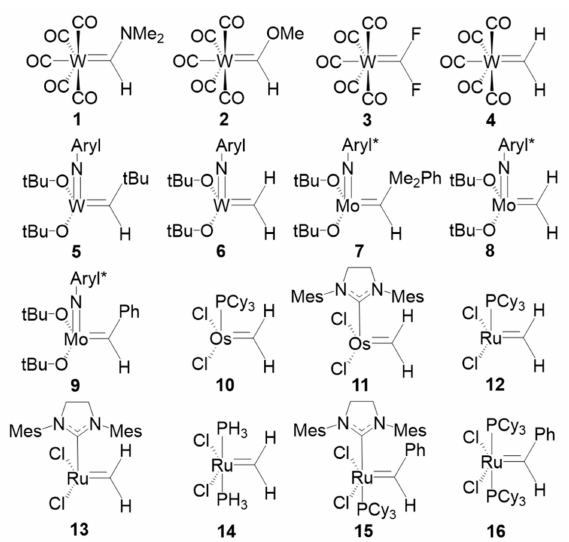
Figure 8. TM carbenes analyzed in this work. Abbreviation: Aryl = 2,6-diisopropylphenyl, Aryl* = 2,6-dimethylphenyl, Cy = cyclohexyl and Mes =